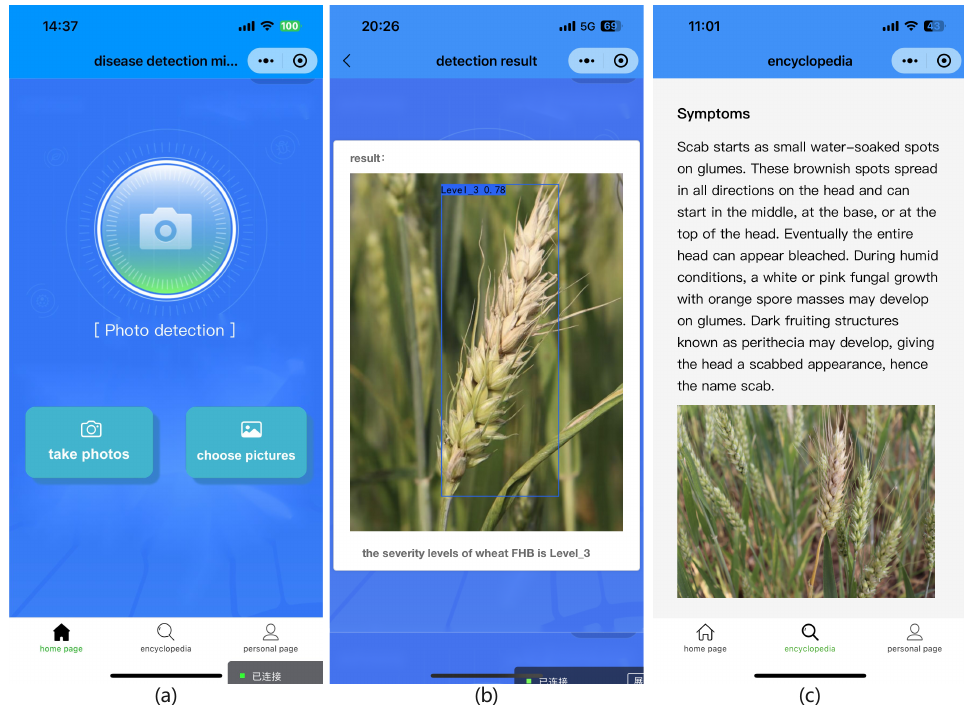
Figure 7. User interfaces of Wechat Mini